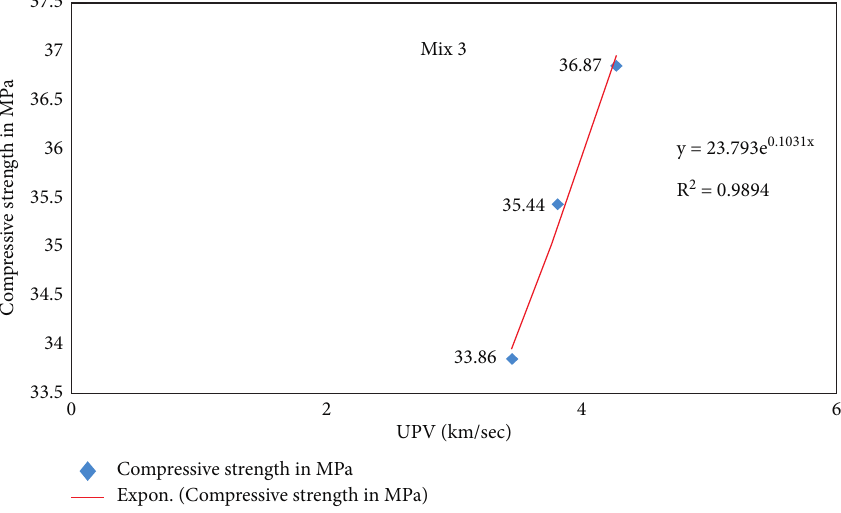
Figure 7: Relation between compressive strength and UPV for Mix 3.